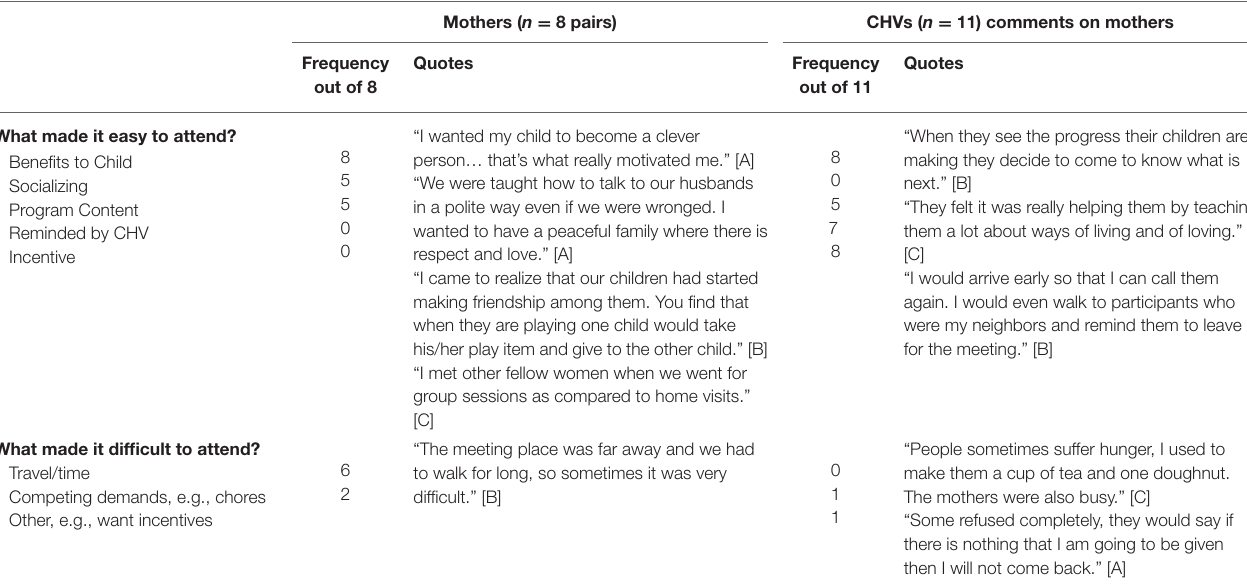
TABLE 5 | Barriers and enablers for caregiver attendance—Mother and CHV